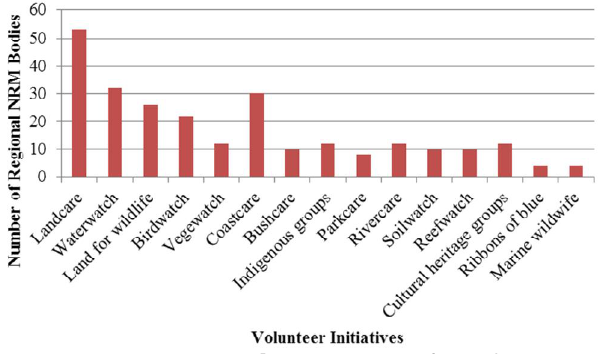
Figure 6. Community volunteer initiatives for catchment management activities